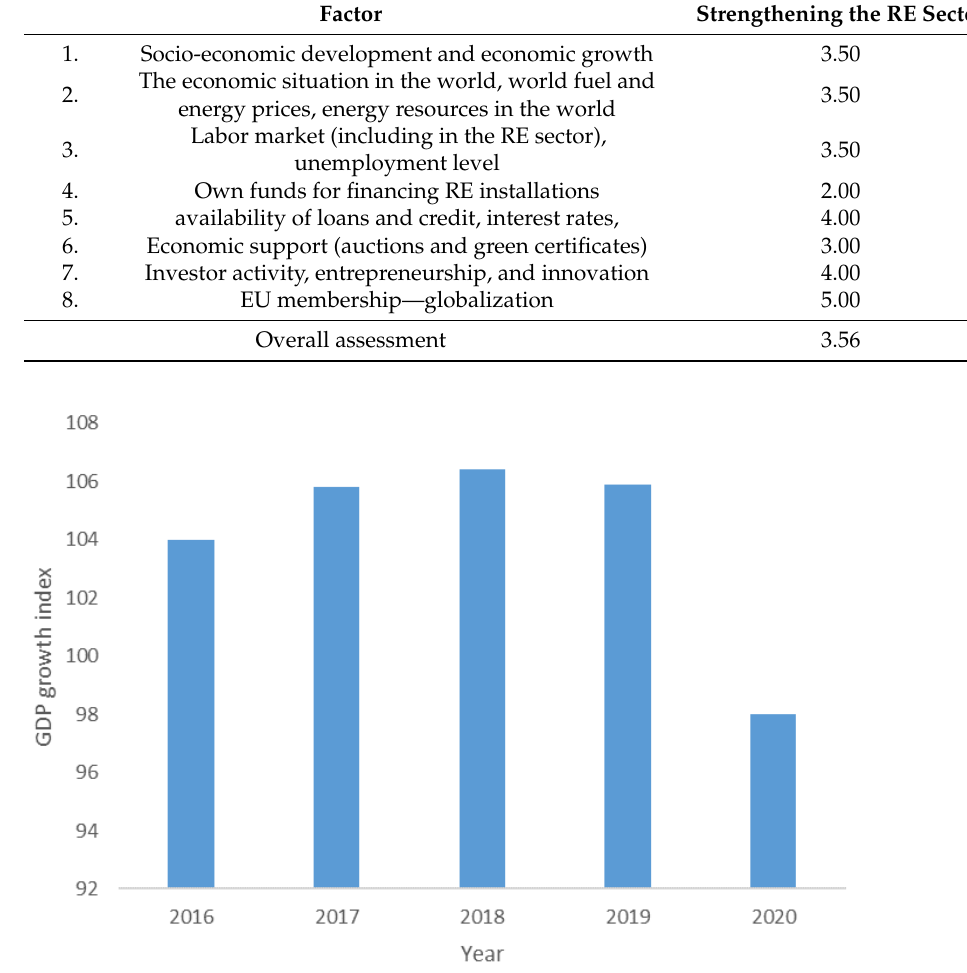
Figure 3. GDP growth index in the years 2016–2020 in Poland (own study from